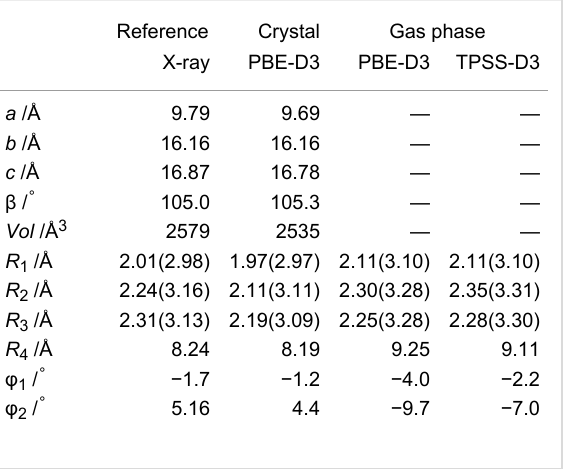
Table 1: Comparison of the X-ray structure of the rotaxane with the computed crystal and gas phase geometries. The structures are opti- mized at the PBE-D3/1000 eV level (TPSS-D3 with the def2-TZVP basis). The first block shows the cell parameters describing the inter- molecular packing, whereas the second block highlights some intramolecular distances and angles (compare with Figure 2). Distances in parentheses denote the corresponding length to the heavy (non-hydrogen) atom.